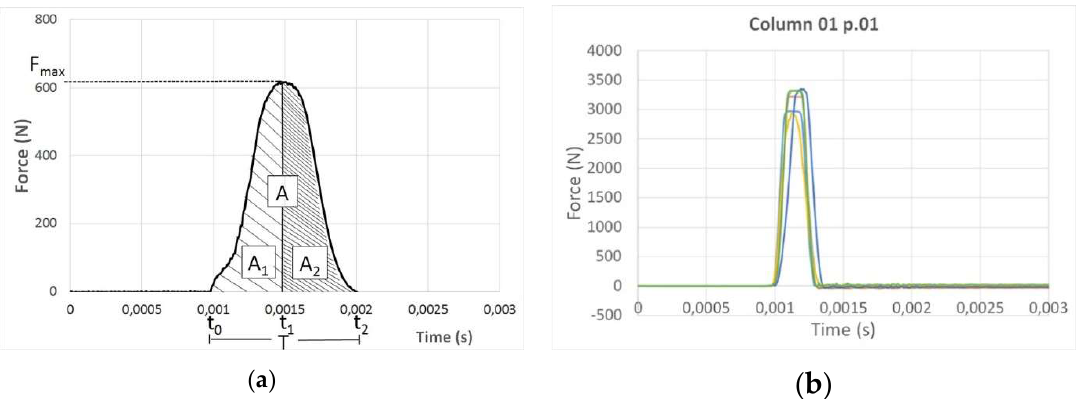
Figure 6. ( a ) Generic force–time diagram of an impact test; ( b ) test results by impact test on column 1 of the portico.